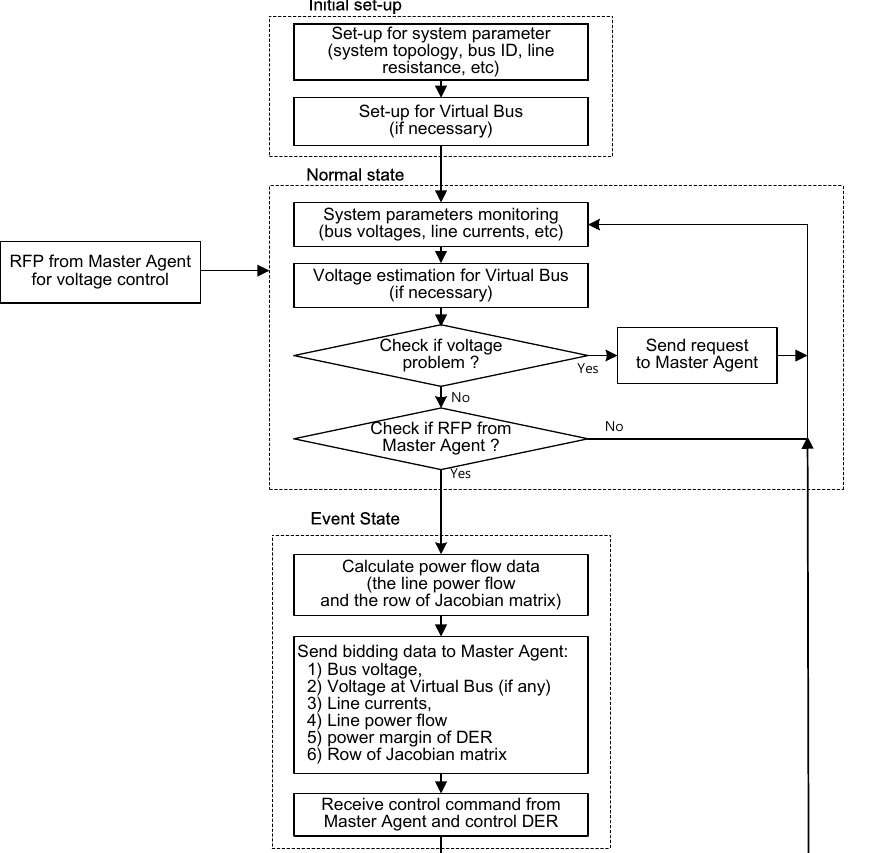
Figure 7. Flow-chart of control actions in local agents.